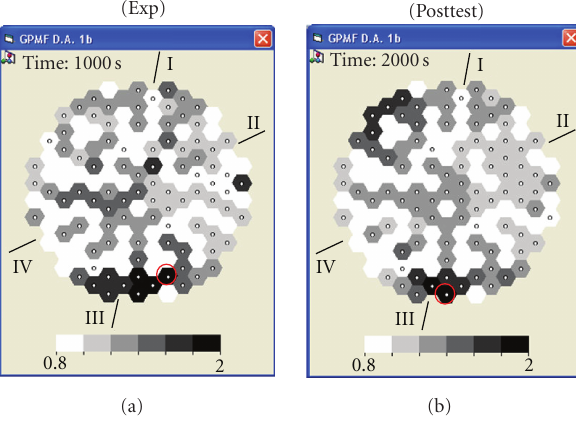
Figure 11: Maps of channel-by-channel accumulated perturbation at 25